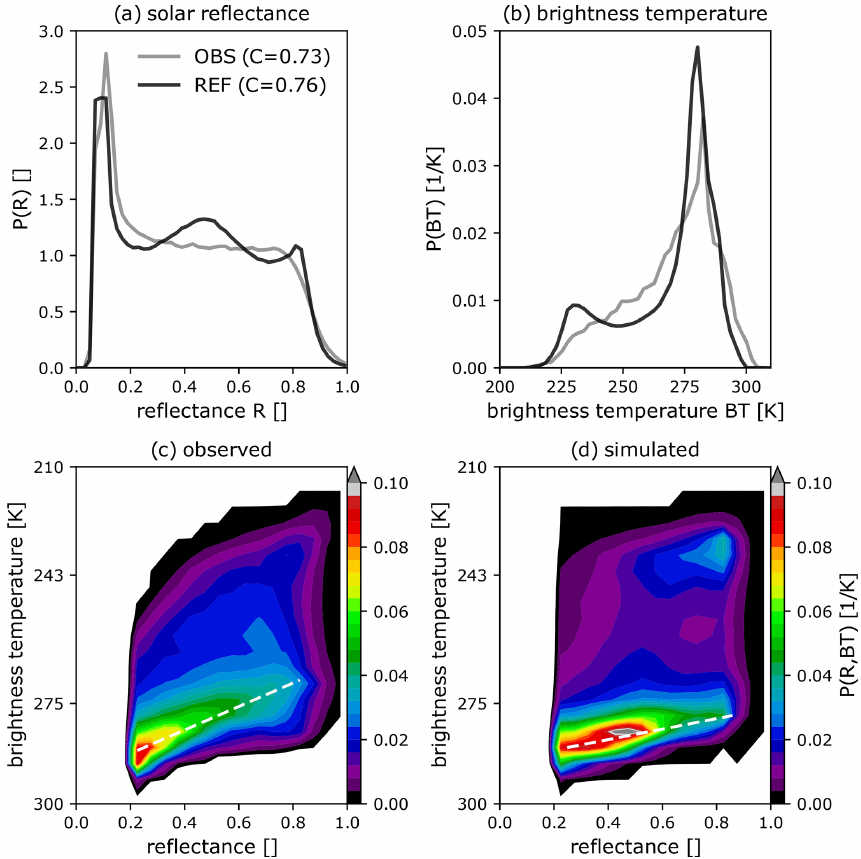
Figure 8. Individual PDFs for 0.6µm SEVIRI solar reflectance (VIS006) (a) , 10.8µm SEVIRI brightness temperature (IR108) (b) and combined VIS006–IR108 PDF (c, d) of observations (c) and simulations (d) at 12:00UTC for the full test period. The numbers in the legend of panel (a) indicate the cloudiness, i.e. the fraction of pixels exceeding a reflectance of